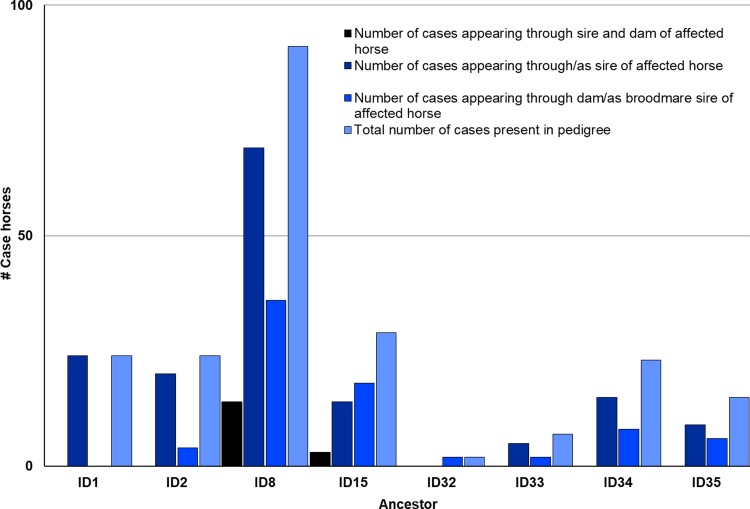
Number of five-generation pedigrees of affected Standardbred racehorses in which the remaining eight significant ancestors appear once through the sire or dam of the horse, or through both.